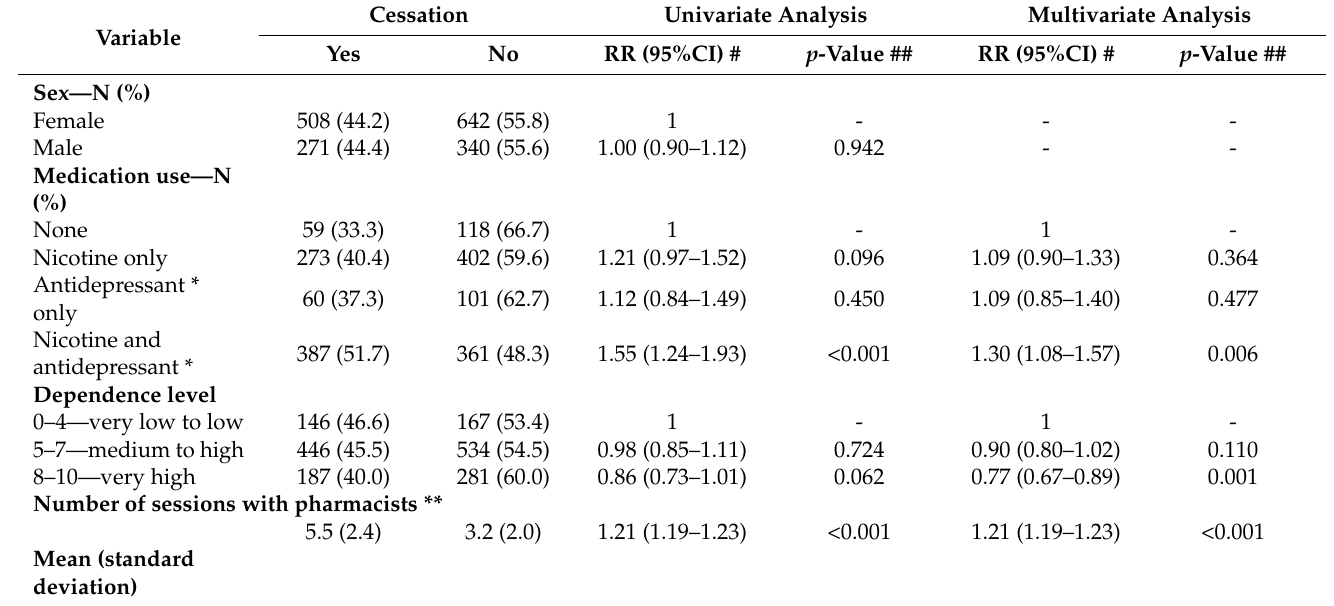
Table 1. Factors associated with smoking cessation according to univariate and multivariate anal- yses. 2018–2019. Belo Horizonte—MG. Brazil.